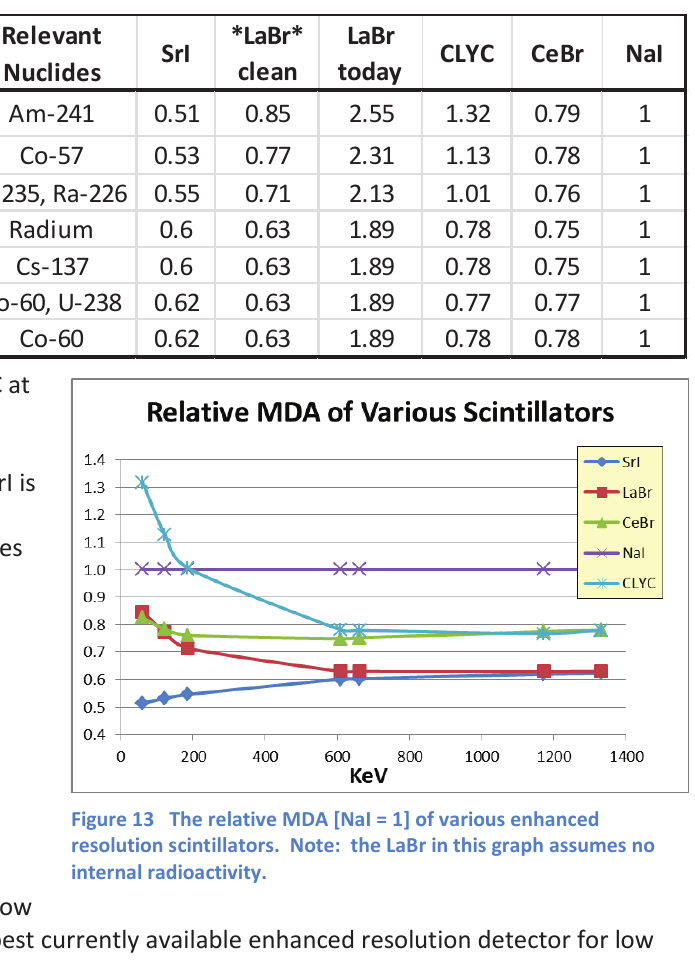
Table 2 Computed Minimum Detectable Activities of various enhanced resolution scintillators as compared to NaI.